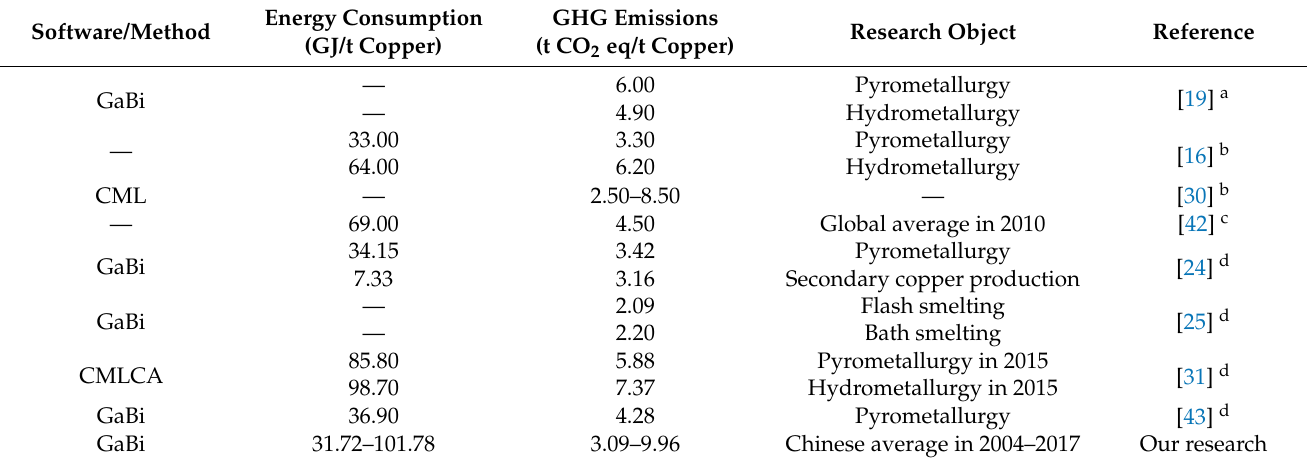
Table 2. LCA results of copper production in different